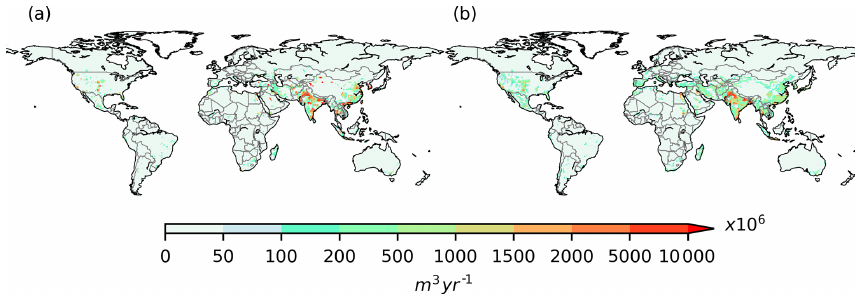
Figure 4. Comparison of irrigation demands simulated by MIROC-INTEG-LAND (a) with the results from offline simulations using HiG- WMAT and (b) forced by observed climate forcing data (Pokhrel et al., 2015) for 1 ◦ × 1 ◦ grids shown as the mean for the 1998–2002 period.